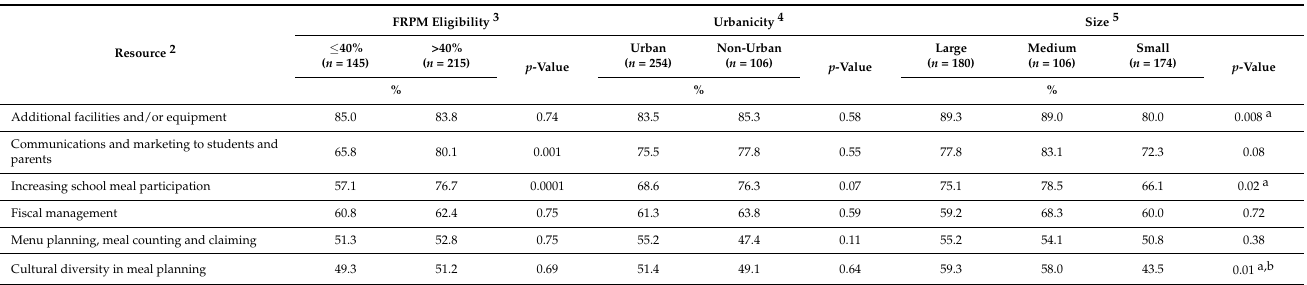
Table 7. Additional resources or information needed for the SY 2022–23 using characteristics noted by Californian school food authorities ( n = 581) 1